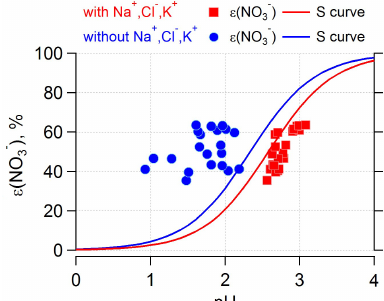
) for PM 2 . 5 (data points) Figure 5. Comparison of measured ε (NO − 3 to S curves, which are predicted from theory and include activity coefficients from ISORROPIA-II. The product of the activity coef- ficients, γ H + γ , was on average 0.28 with Na + , Cl − , and K + NO − 3 and 0.19 without Na + , Cl − , and K + . In both cases pH (data points) is predicted by